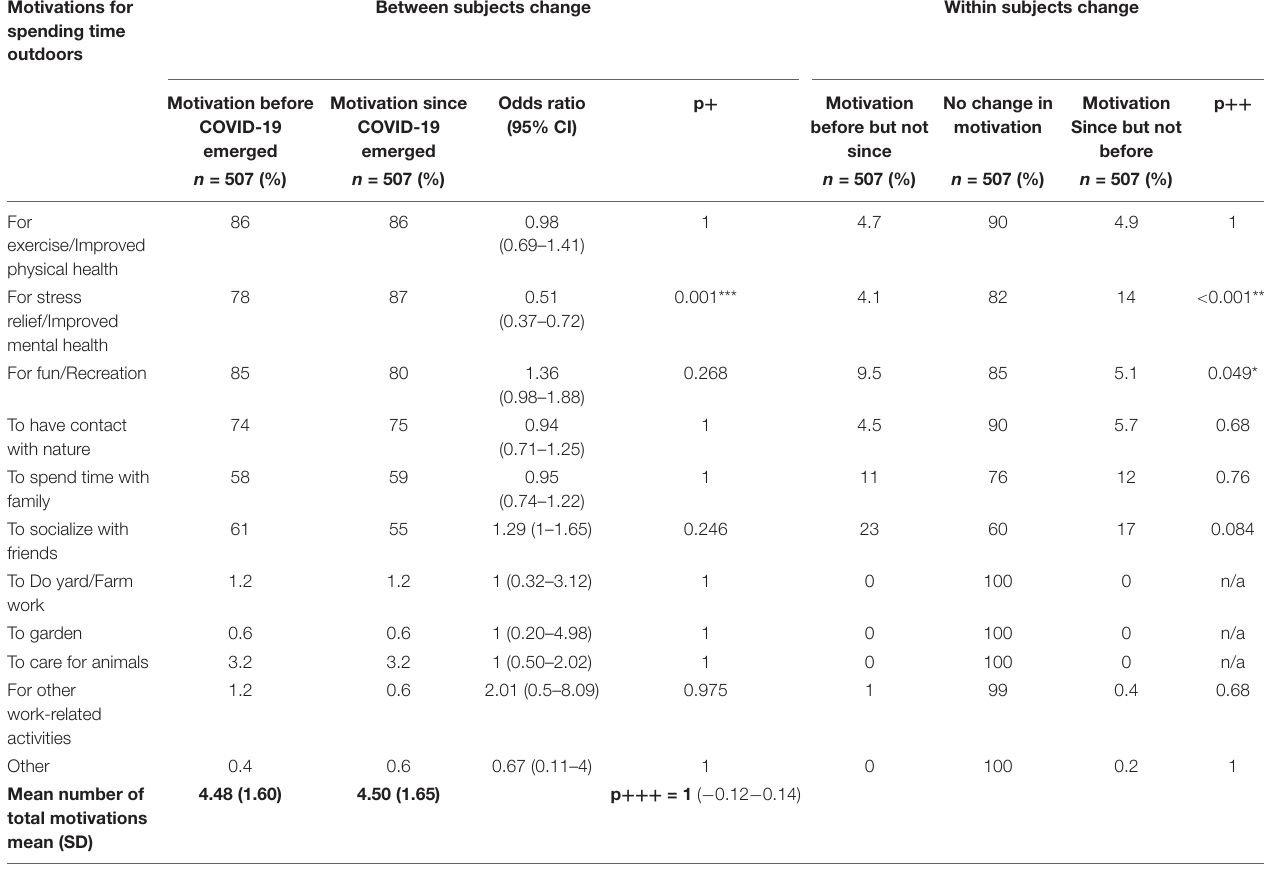
TABLE 6 | Changes in motivations for spending time outdoors in nature. Motivations for spending